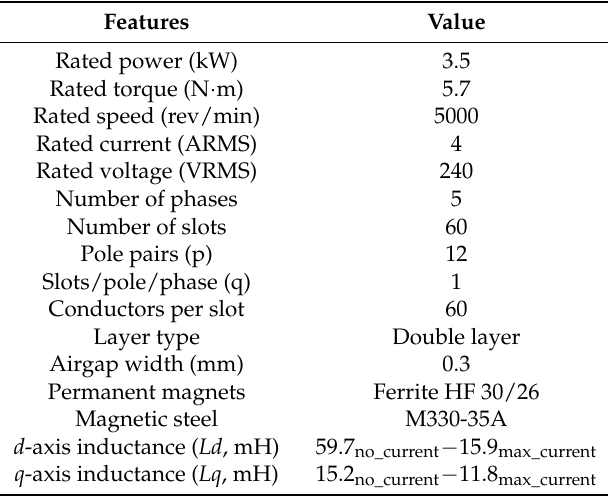
Table 1. Main features of the analyzed fPMa-SynRM.